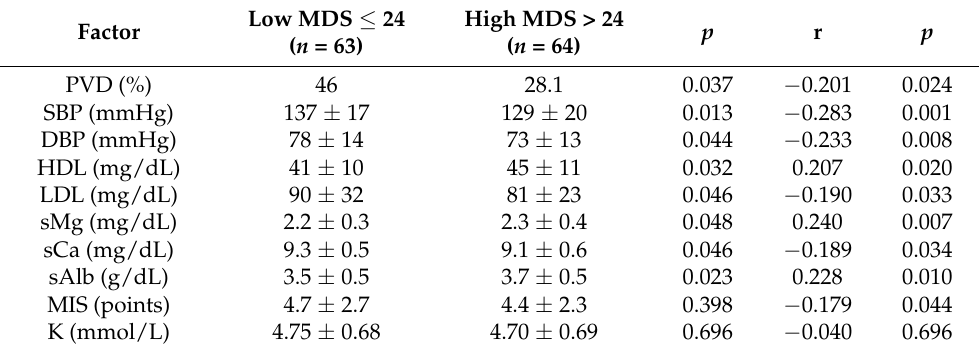
Table 5. Factors associated with